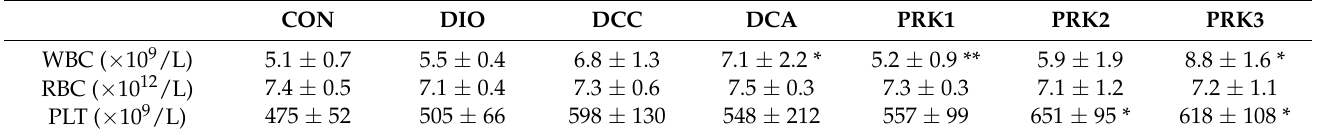
Table 1. Peripheral blood cell counts in Wistar rats at the end of the experiments ( n = 10 in each group). *— p < 0.05 vs. CON group; **— p < 0.05 vs. DCA group. WBC—white blood cells, RBC—red blood cells, PLT—platelets. Group names are specified in the text.